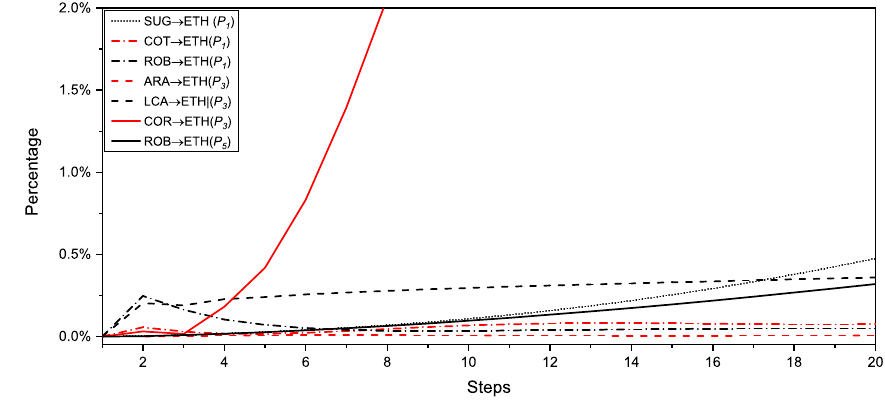
Figure 6. The FEVD of the agricultural commodities prices in the ethanol